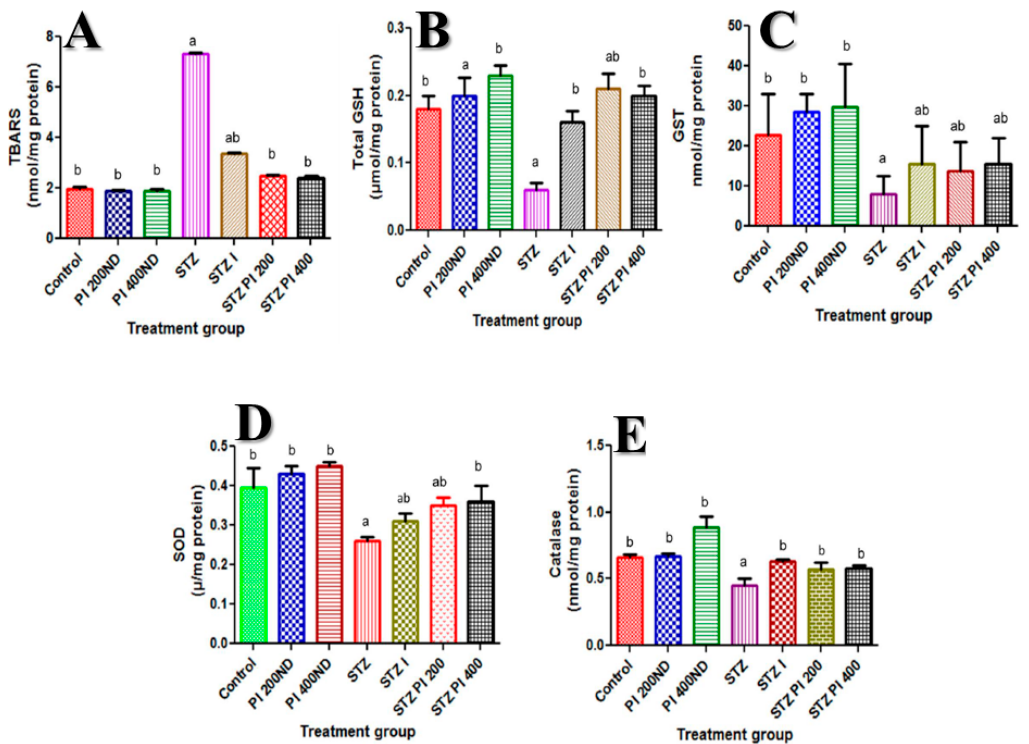
Figure 3. Effect of PBPi on assessment of oxidative stress and antioxidants. ( A ) TBARS (nmol/mg protein), ( B ) Total GSH ( µ mol/mg protein), ( C ) GST (nmol/mg protein), ( D ) SOD ( µ /mg protein), ( E )